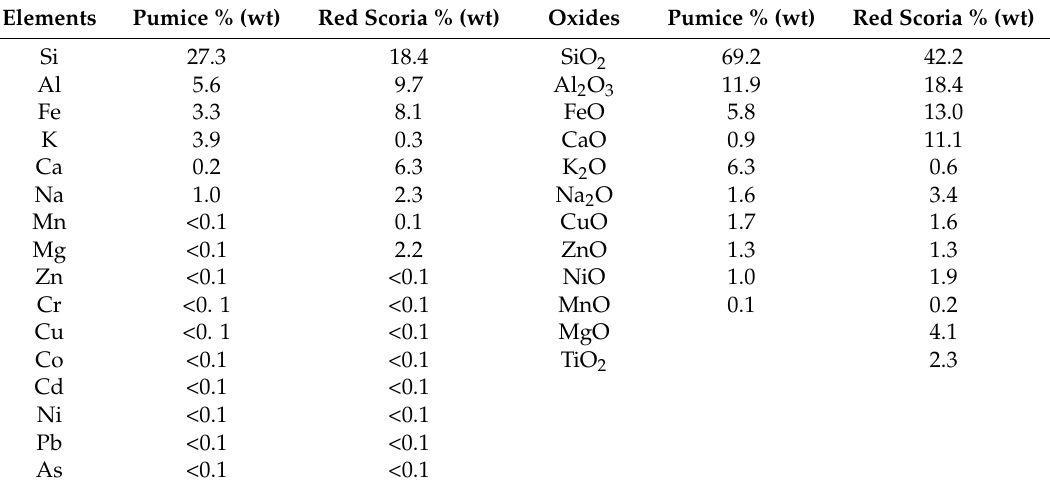
Table 1. Elemental composition and oxide content of red scoria and